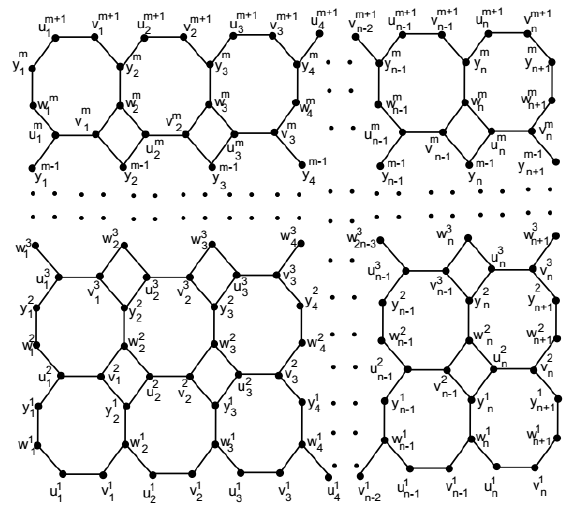
Figure 1. The Octagonal grid O m n